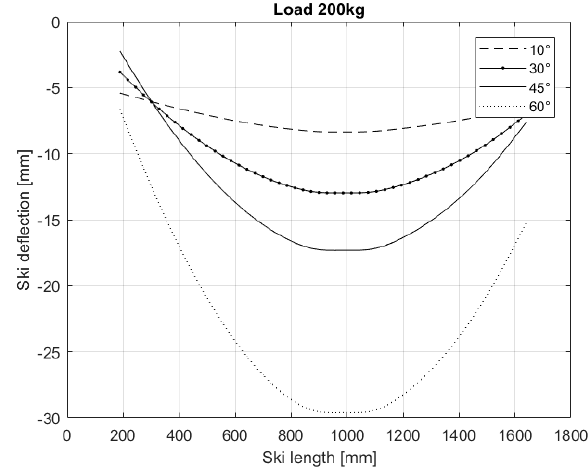
Figure 19. Deflection of the ski for different roll angles and 200 kg.